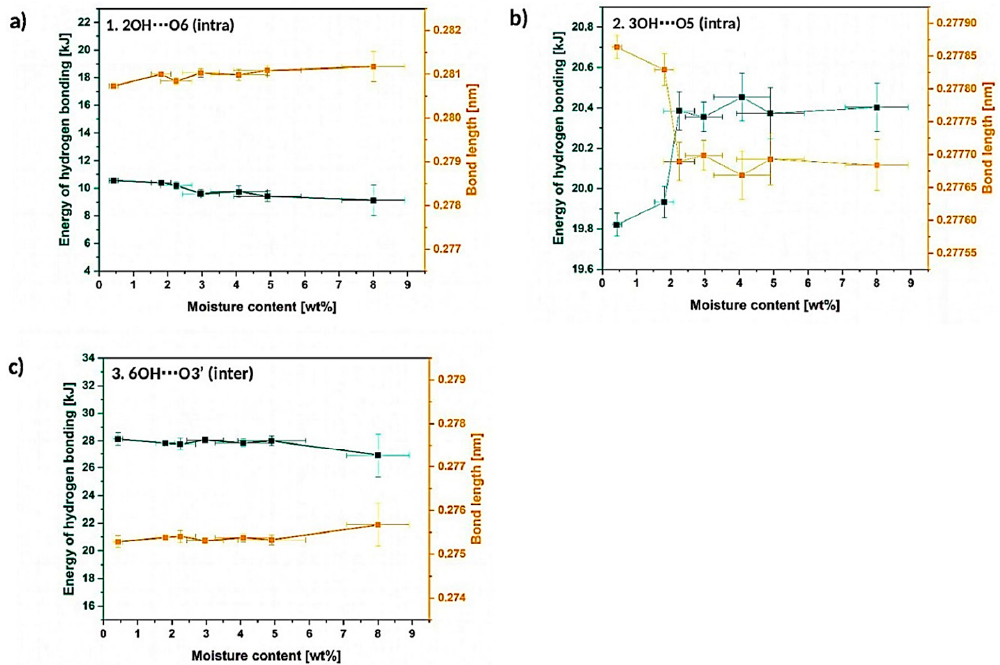
Figure 7. Graphs illustrating energy and length of hydrogen bonds assigned to the resolved signals: ( a ) 2OH ⋯ O6, ( b ) 3OH ⋯ O5, ( c ) 6OH ⋯ O3 ′ . Peak assigned to 3OH ⋯ O5 intramolecular hydrogen bond shifts in the direction of lower wavenumber, while the peaks attributed to 6OH ⋯ O3 ′ intermolecular hydrogen bond and 2OH ⋯ O6 intramolecular hydrogen bond move toward higher wavenumber. This may indicate some energy and bond length variations between the analyzed hydrogen interactions.